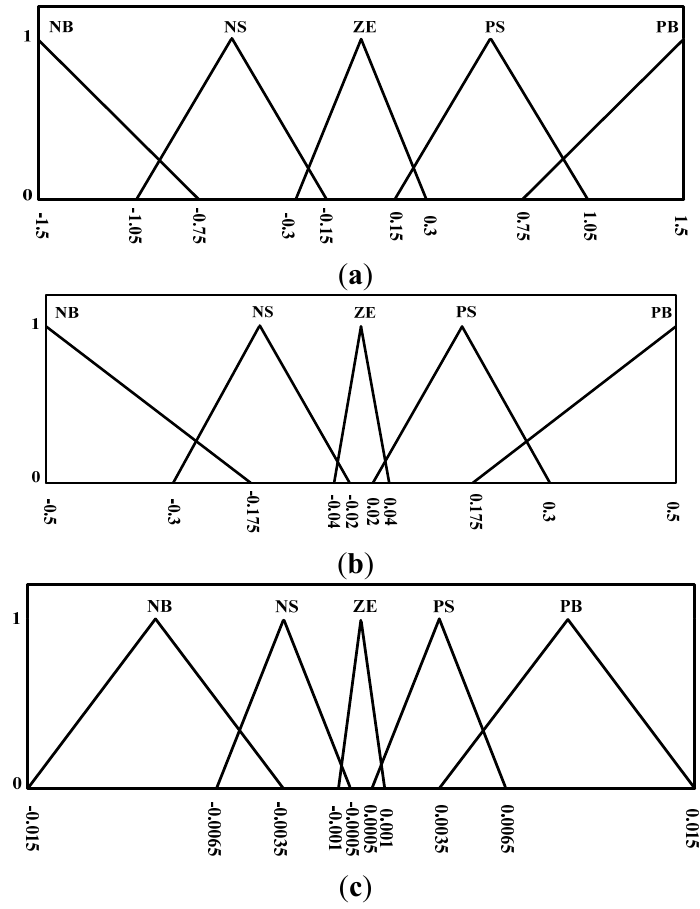
Figure 12. Fuzzy rules for Algorithm (iii) using P  and V  as the inputs.